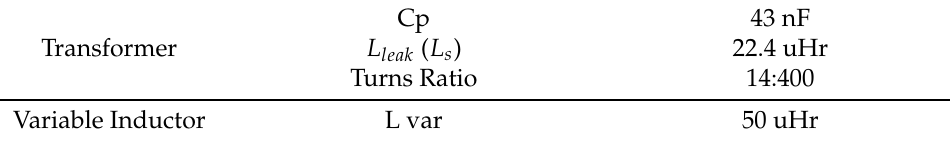
Figure 6. The inverter. Table 1. Resonant tank